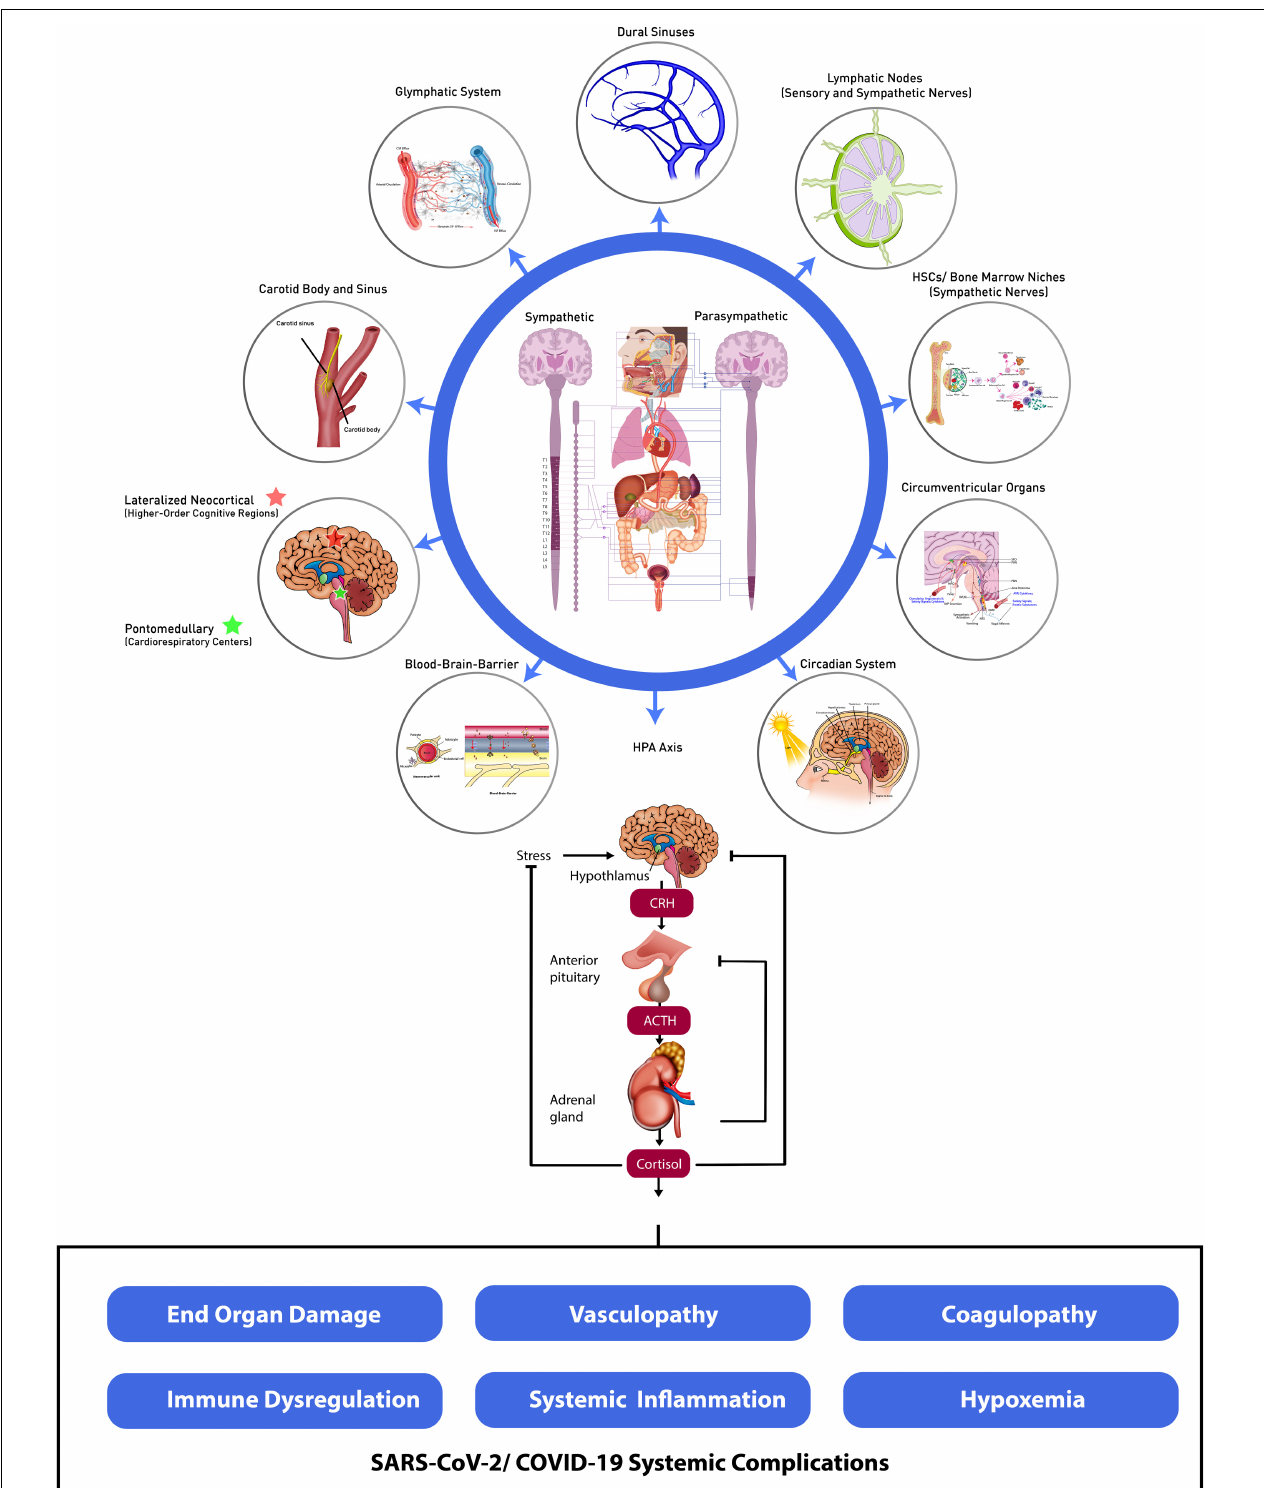
FIGURE 1 | Dynamic neural-systemic interactions mediating SARS-CoV-2 infection. CSF, cerebrospinal fluid; ISF, interstitial fluid; HSCs, hematopoietic stem cells; SFO, subfornical organ; PVN, paraventricular nucleus; PBN, parabrachial nucleus; DMV, dorsal motor nucleus of the vagus; NTS, nucleus tractus solitarius; RVLM, rostral ventrolateral medulla; OVLT, organum vasculosum of the lamina terminalis; MPO, myeloperoxidase; AVP, arginine vasopressin; HPA, hypothalamic–pituitary–adrenal; CRH, corticotrophin-releasing hormone; ACTH, adrenocorticotropic hormone.